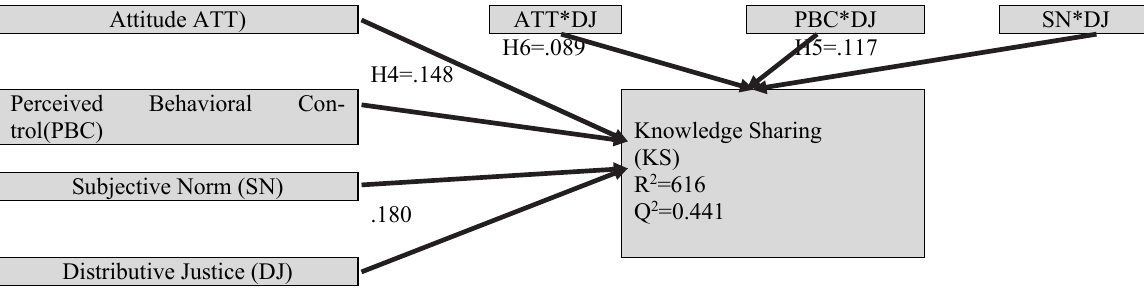
Fig. 2. Results of the Structural Model for Moderation Effects of Distributive Justice